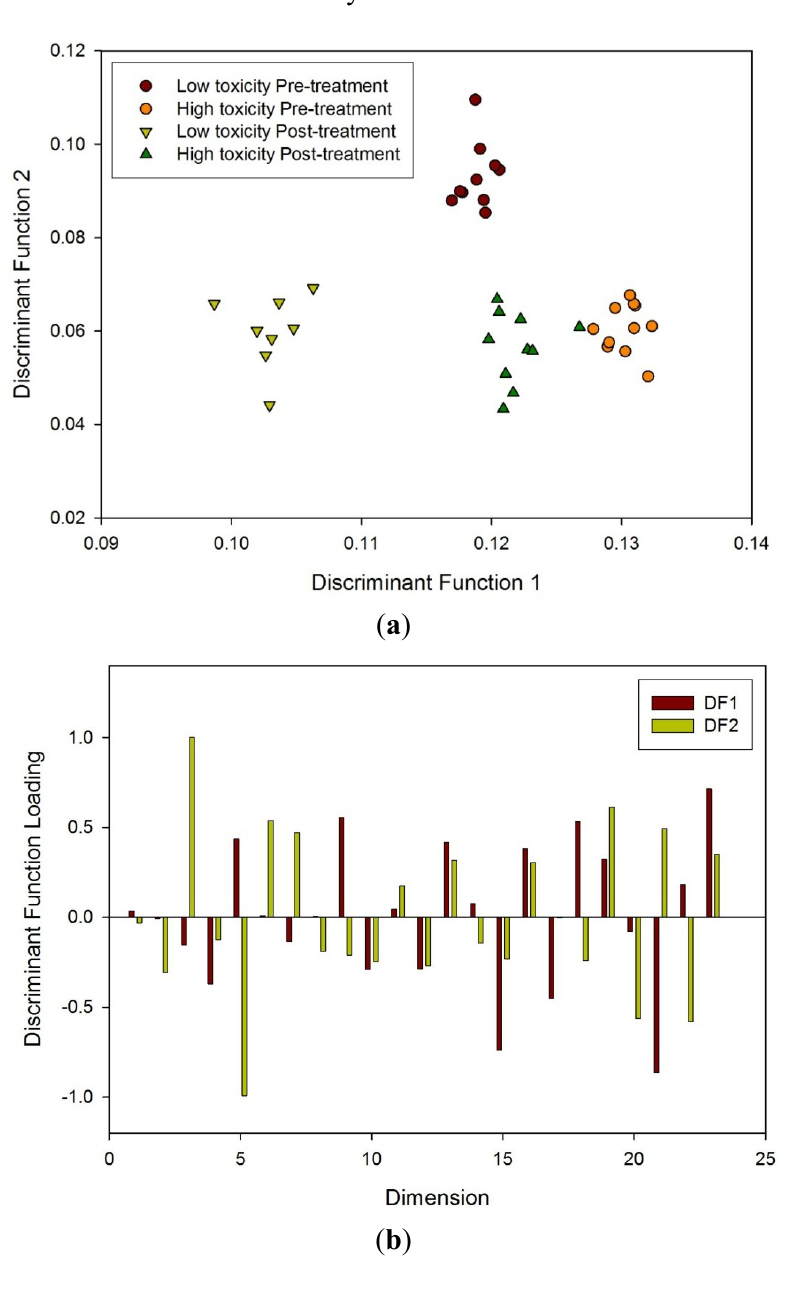
Figure 8. ( a ) FDA of FAIMS data to all four groups and ( b ) loading plot associated with FDA using dimensions created in the analysis described